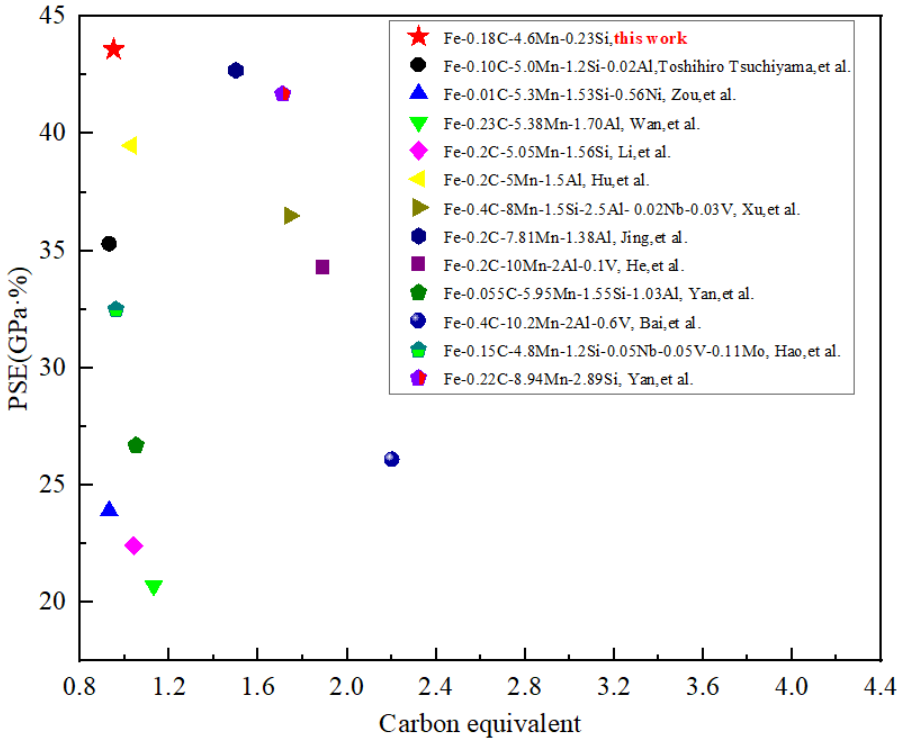
Figure 6. PSE values versus carbon equivalent of this work, compared to reported results [9,10,22–